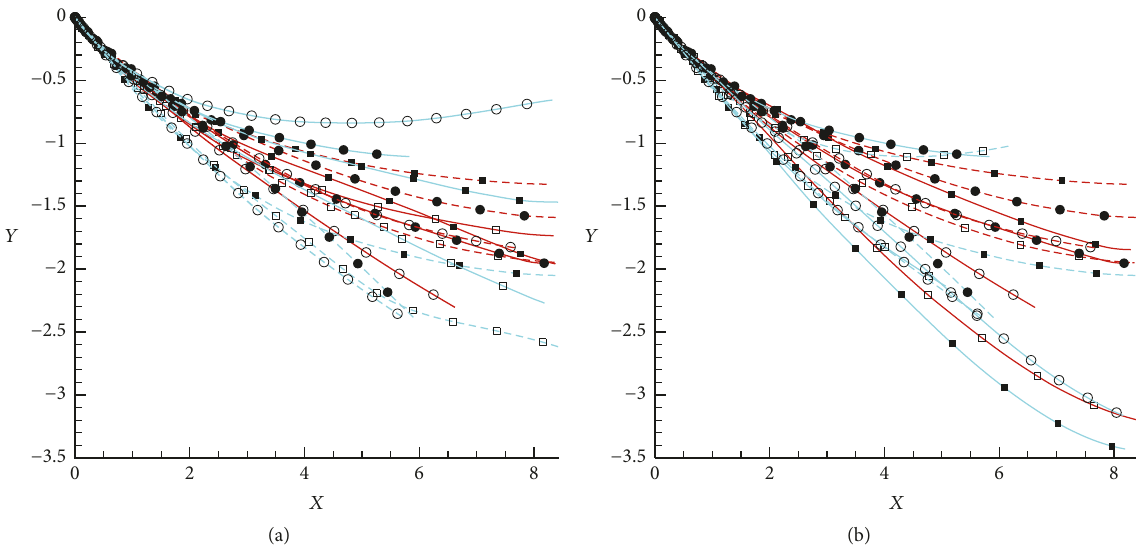
Figure 10: Dimensional trajectories representative of the test matrix for a negative starting angle of the plate; Red Fr number 51.7 ; Blue Fr number 66.6 ; square Re number 8750 ; circle Re number 5250 ; filled symbols K 37.5 ; empty symbols K 22.5 ; line inertia parameter 8.52×10 −2 ; dashed line inertia parameter 8.35 × 10 −2